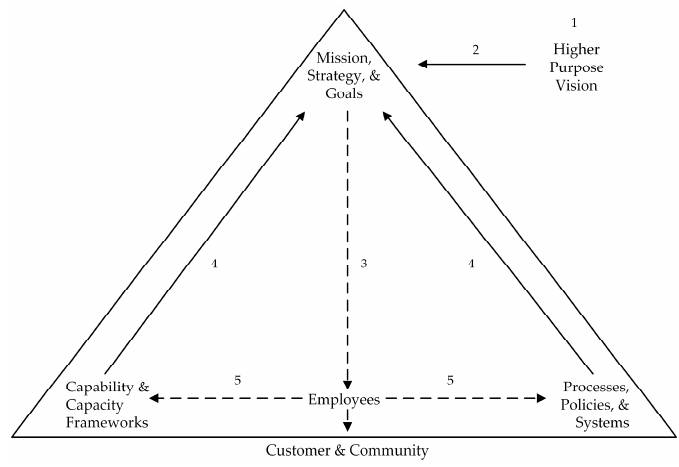
Figure 1. Process to set, translate, and execute a higher purpose vision.